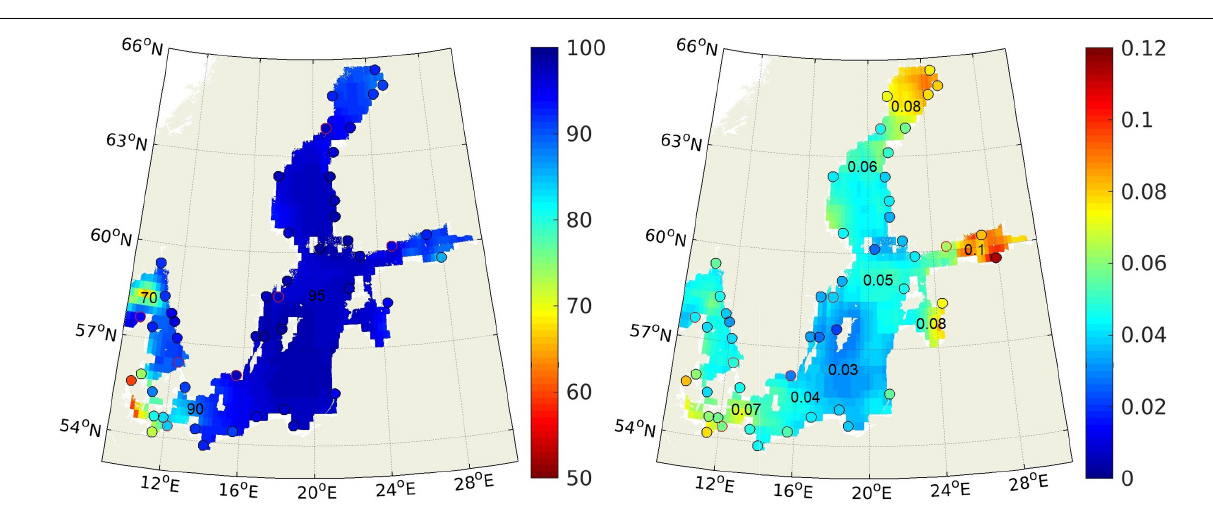
FIGURE 6 | Validation of monthly SLV_CCI against SLV_TGval (dots with black edges, nearest neighboring point), SLV_TGin (dots with red edges, nearest neighboring point) and reconstructed sea level (colored areas). Left: correlation (%), Right: RMS difference